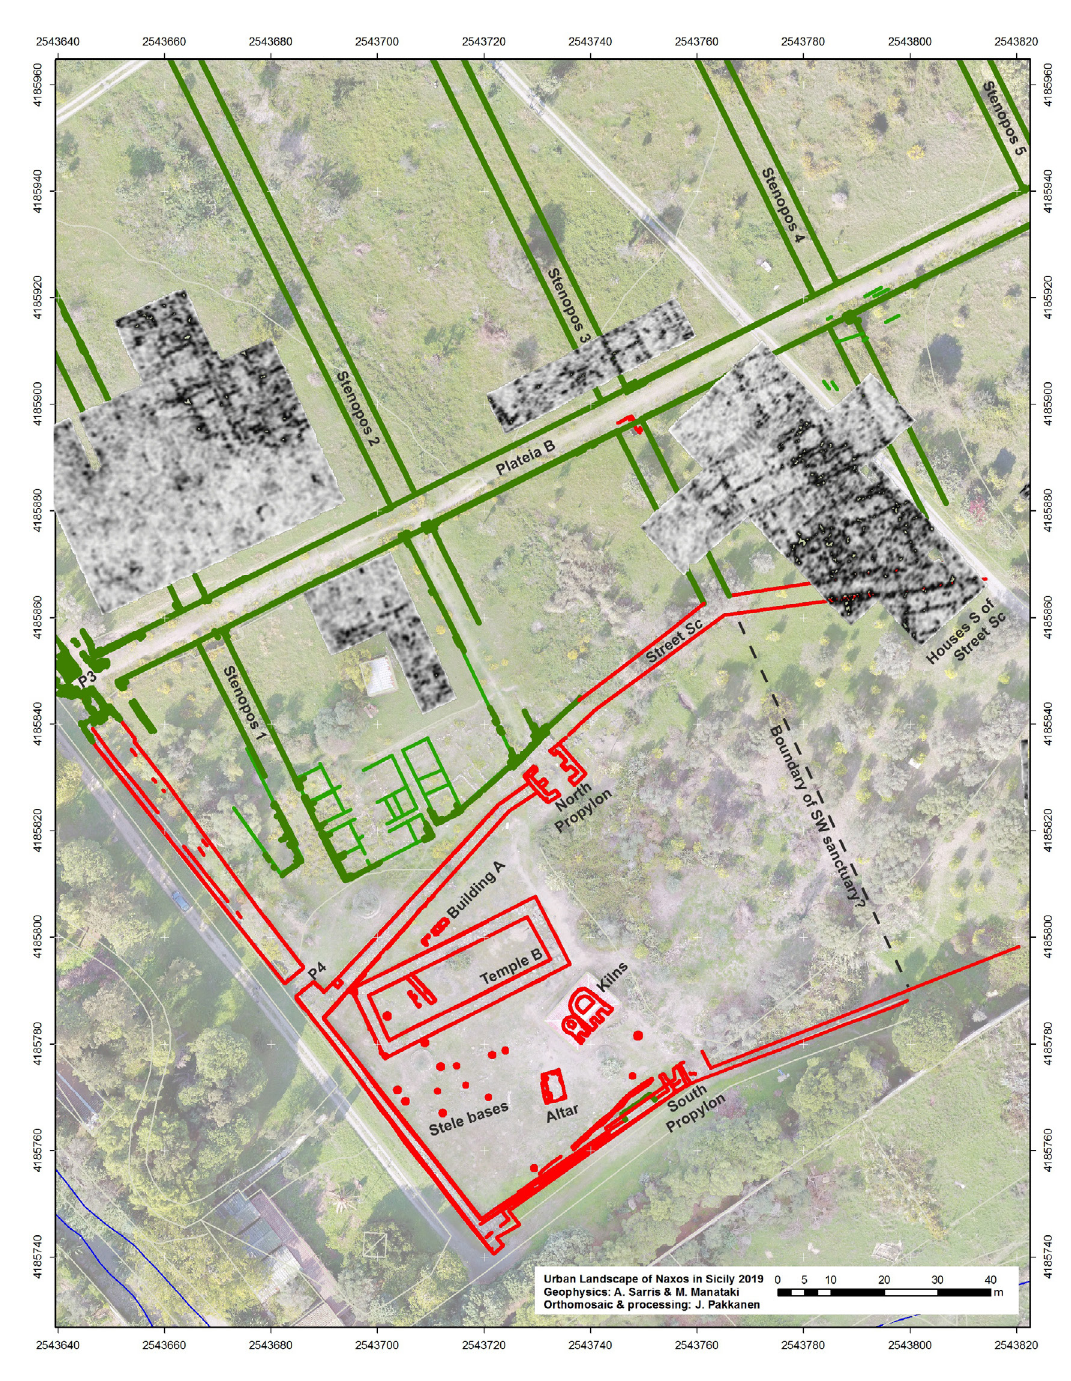
Figure 8. South-west sector of Naxos. Excavated remains and GPR grids superimposed on the aerial orthomosaic. Red = Archaic; green = Classical (Jari Pakkanen, Apostolos Sarris, & Meropi